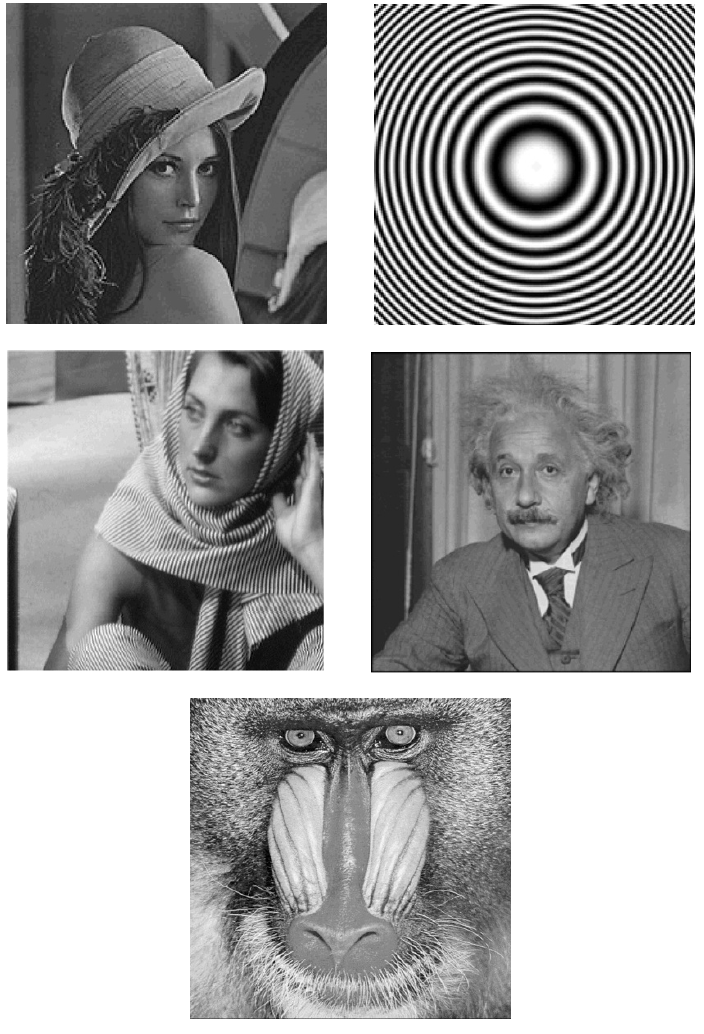
Figure 2: Images used for